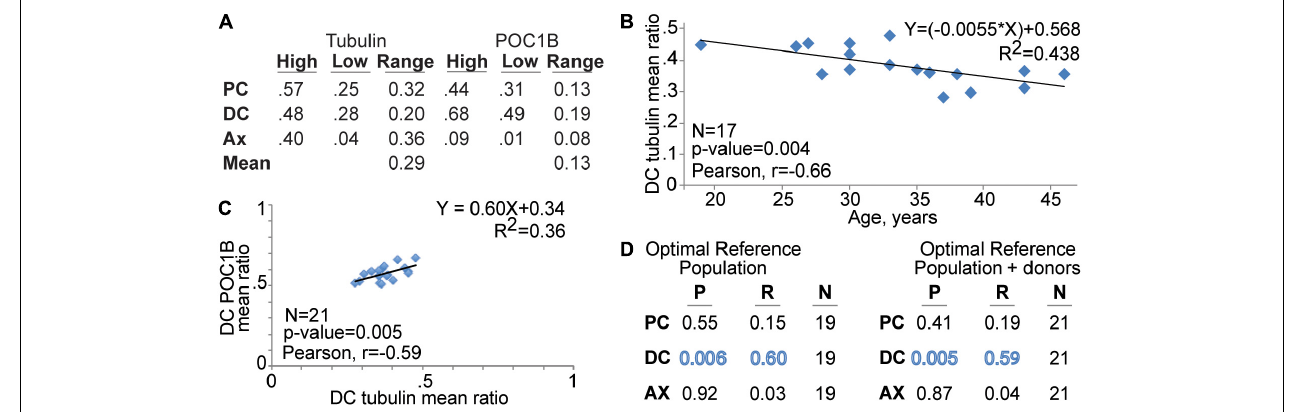
FIGURE 3 | The of DC’s tubulin mean ratio corelate with patient age and DC POC1B. (A) Tubulin mean ratio range is wider than POC1B mean ratio range. Table shows the centriole marker mean ratio range of the reference population at the PC, DC, and Ax as well as centriole marker combined mean ratio range in the pellet sperm (Mean). (B) FRAC finds that the tubulin level in the DC is reduced with patient age. (C) Graph depicting the Correlation of DC POC1B and DC tubulin mean ratios in the Optimal Reference Population. (D) Table summarizing the correlation P value (P), Pearson R value (R), and number of men (N) of Tubulin and POC1B patient mean